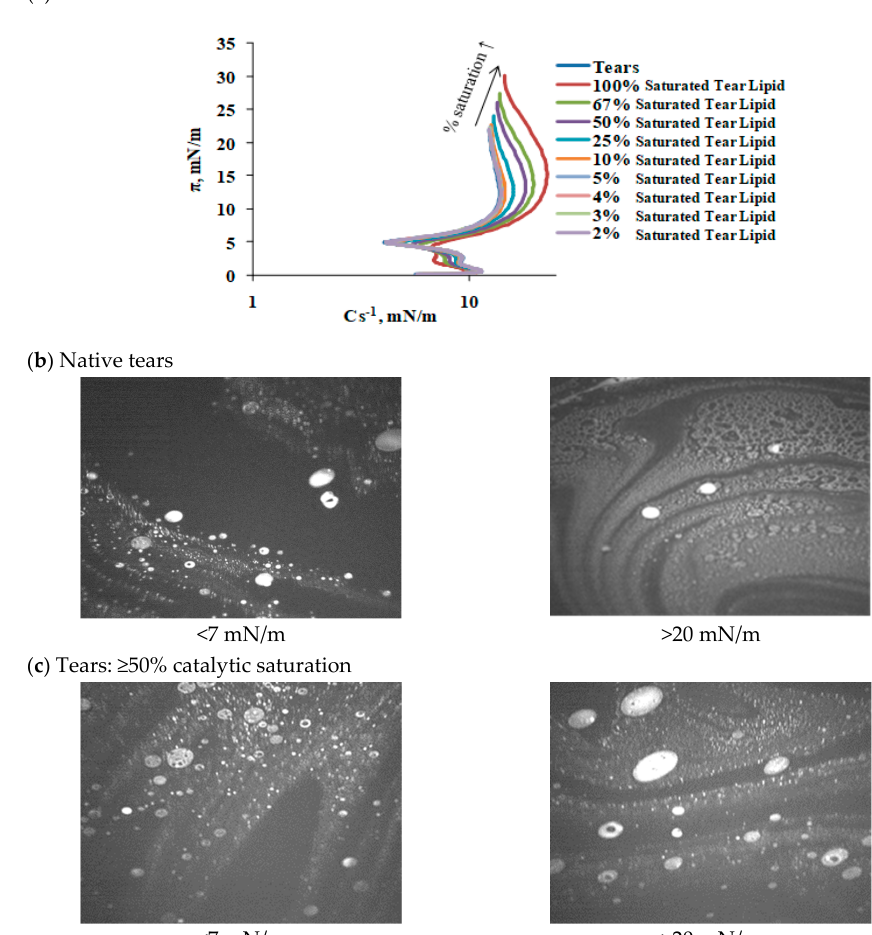
Figure 6. The increase in saturation shifts the reciprocal compressibility modulus to higher values at higher surface pressures ( a ), however, at low π values, the curves are almost identical. This suggests that the spreading and phase coexistence in tear layers are tolerant to catalytic saturation. This is well illustrated by the Brewster angle microscopy (BAM) micrographs ( b , c ). Int. J. Mol. Sci. 2019 , 20 , x